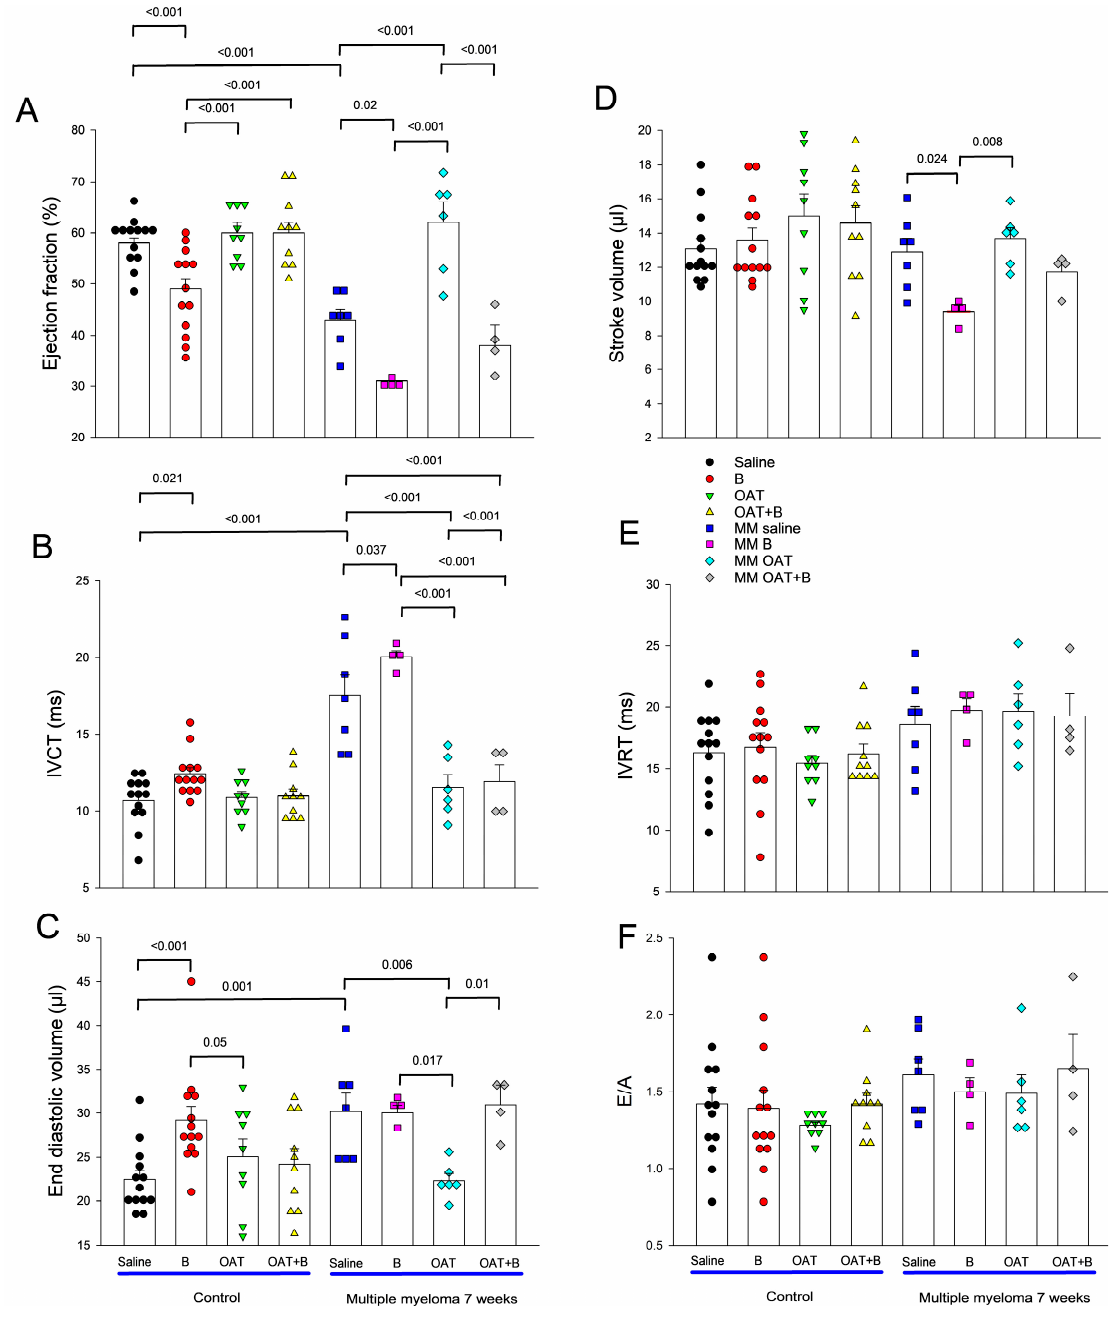
Figure 3. Effects of a proteasome inhibitor, bortezomib, arginase inhibitor, OAT-1746 and their combination on parameters of systolic and diastolic left ventricular function and dilation in healthy and multiple myeloma mice measured by echocardiography. Parameters of left ventricular [LV] systolic function, ejection fraction ( A ) and isovolumic contraction time [IVCT] ( B ), a measure of LV dilation, end-diastolic volume ( C ), a measure of global LV function, stroke volume ( D ), and parameters of LV diastolic function, isovolumic relaxation time [IVRT] ( E ) and E to A wave ratio [E/A] ( F ) and are shown; saline, saline-treated control mice; B, bortezomib-treated control mice; OAT, OAT-1746-treated control mice; OAT+B, OAT-1746 and bortezomib combination treated control mice; MM saline, saline-treated multiple myeloma (MM) mice; MM B, bortezomib-treated MM mice; MM OAT, OAT-1746-treated MM mice; MM OAT+B, OAT-1746, and bortezomib combination treated MM mice; graph presents means ± SD; n = 4–14; p values were calculated with one-way ANOVA with Tukey’s posthoc